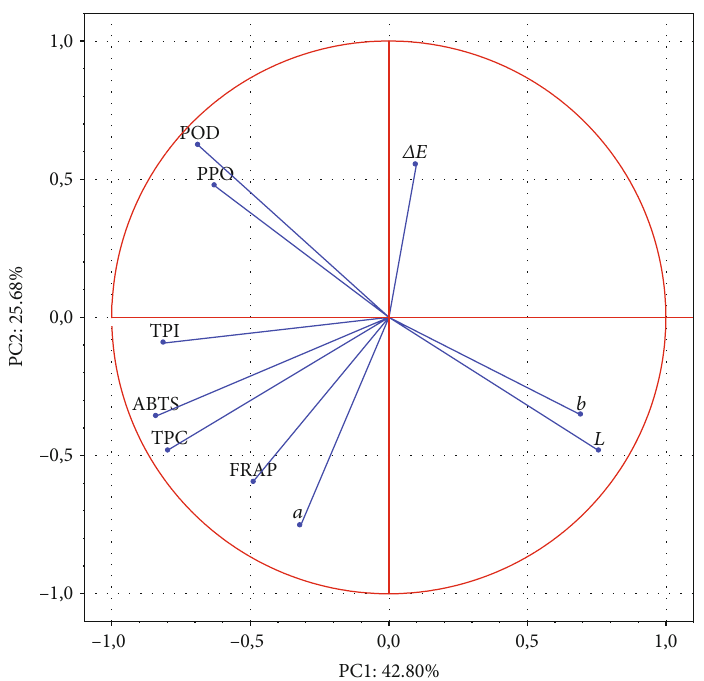
Figure 3: Principal component plot, variations in the parameters (TPC, TPI, ABTS, FRAP, L ∗ , a ∗ , b ∗ , Δ E , PPO, and POD) of untreated, HHP-treated, and pasteurized (HPT and LPT) tomato juice upon 0, 7, and 14 days of storage. Table 3: Pearson correlation coe ffi cient indicating the relationship between the tested parameters in untreated, HHP-treated, and pasteurized (LPT and HPT) tomato juice after 0, 7, and 14 days of storage.